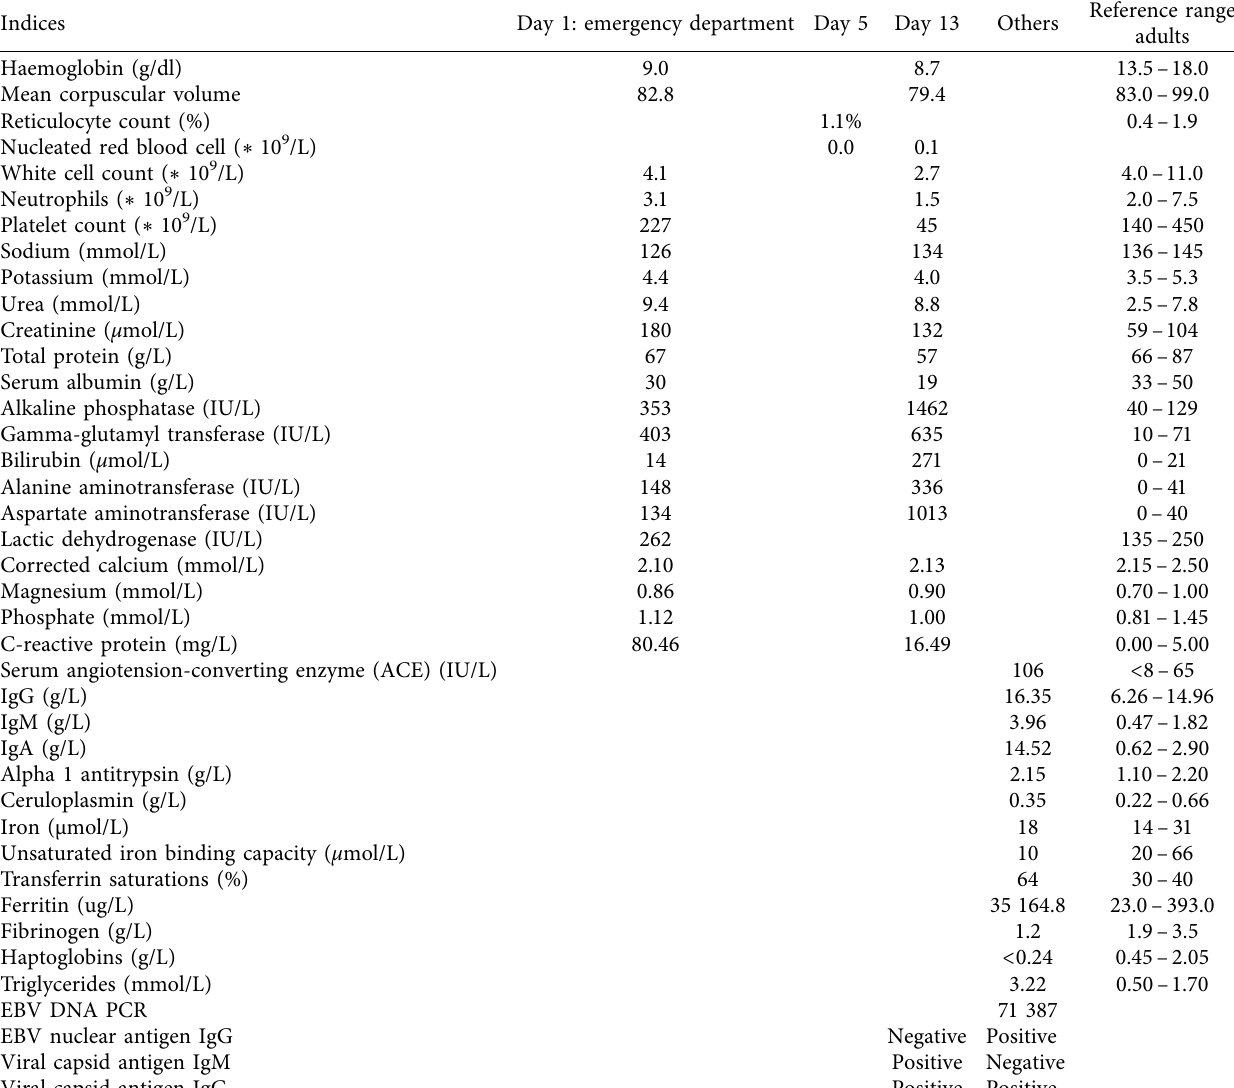
Table 1: Laboratory